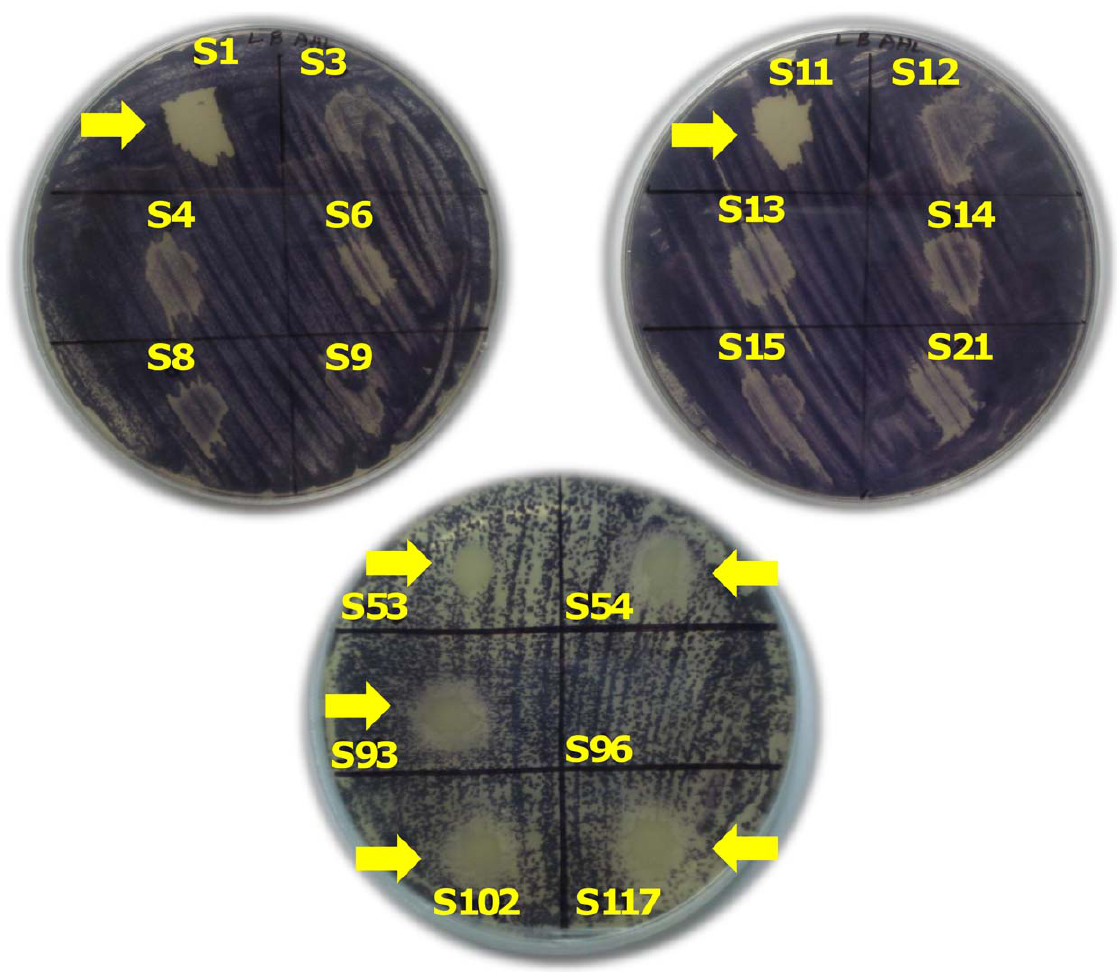
Figure 2. Agar plate assays for screening the production of acylated homoserine lactone (AHL) in Acinetobacter spp. clinical isolates using Chromobacteriumviolaceum CV026 (Inhibition) as monitor system. All the seven isolates that tested positive for long-chain AHLs are shown.